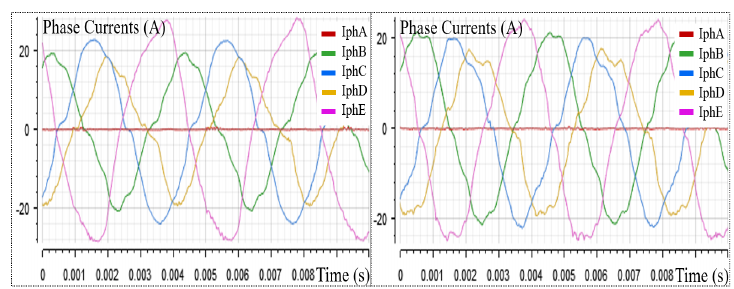
Figure 17. Minimization of the 2nd harmonic impact in healthy condition: before ( left ) and after ( right ), 25A-25600RPM operating point. ( right ), 25A-25600RPM operating